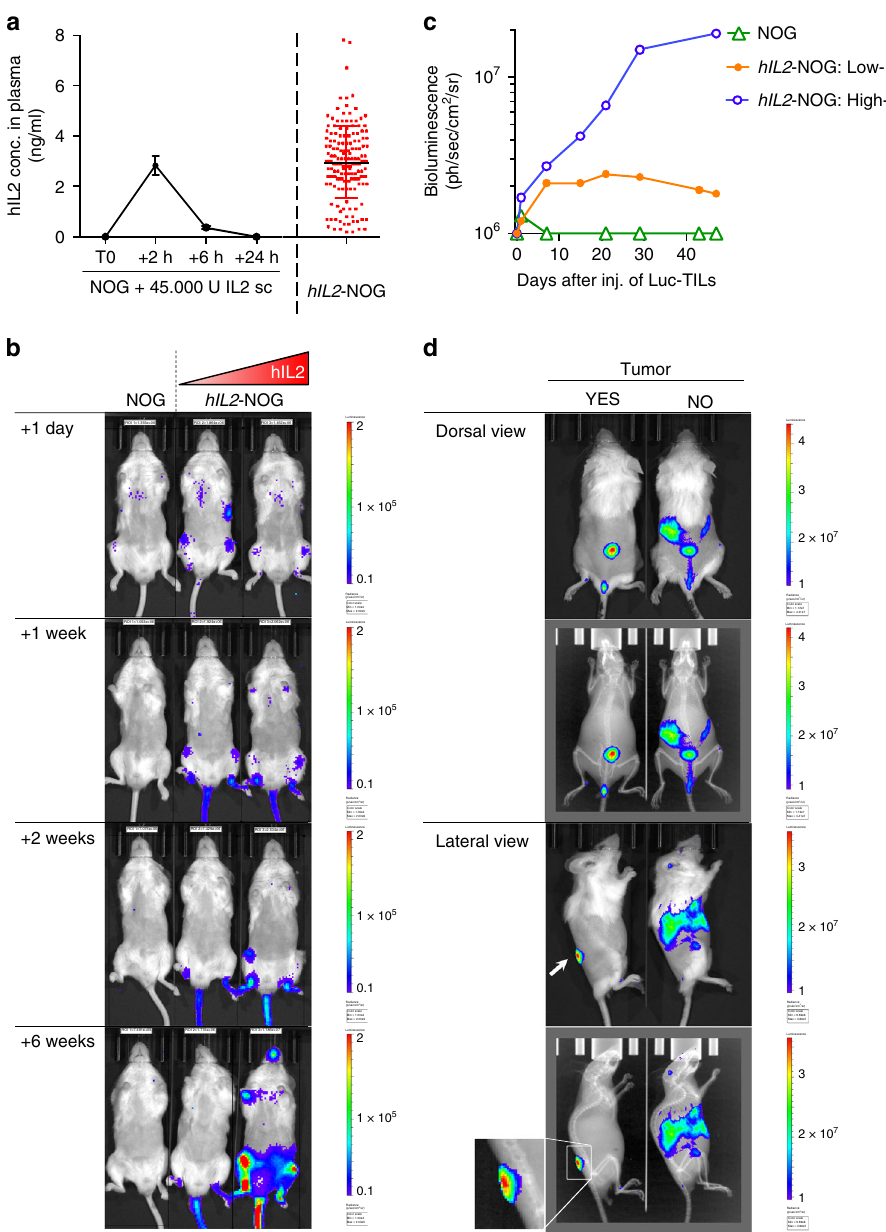
Fig. 2 Transgenic expression of human IL-2 enables NOG mice to support viability of TILs. a Changes in IL-2 plasma levels in NOG mice injected with 45,000 U IL-2 over time and steady-state levels of IL-2 in hIL2 -NOG mice. b In vivo bioluminescence images over time of two hIL2 -NOG transgenic mice with different serum levels of hIL-2 injected with MM33 TILs labeled with a luciferase lentivirus. c Quanti fi cation of radiance of luciferase-expressing MM33 TILs growing in mice (from b ) with different serum levels of IL-2. d In vivo bioluminescence images from different angles of tumor-bearing or non- tumor-bearing hIL2 -NOG transgenic mice injected with luciferase-expressing MM33 TILs. The experiments shown here were performed